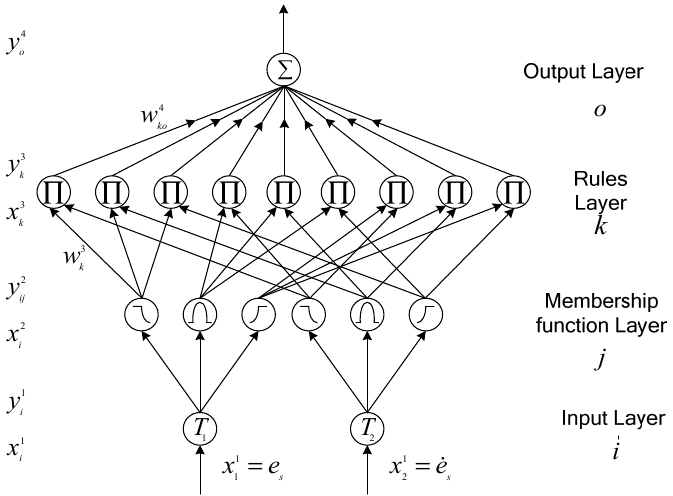
Figure 7. The proposed synchronous control methods of the gantry robot: ( a ) parallel control method; ( b ) parallel master–slave control method.